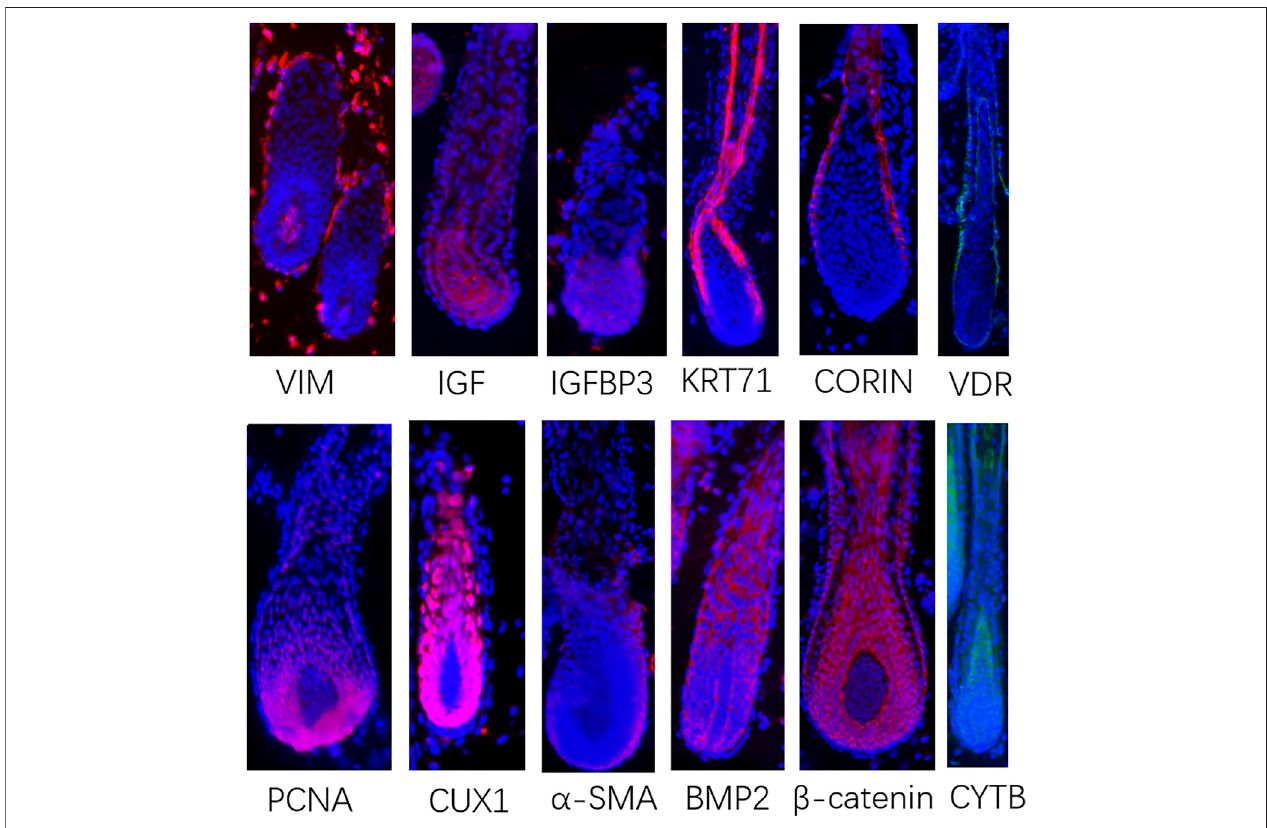
FIGURE 2 | Immuno fl uorescence in skin tissue sections to verify the signature genes came from scRNA-seq. Red or green fl uorescence indicates the expression pattern of target protein. Nucleus was stained with Hoechst in blue.